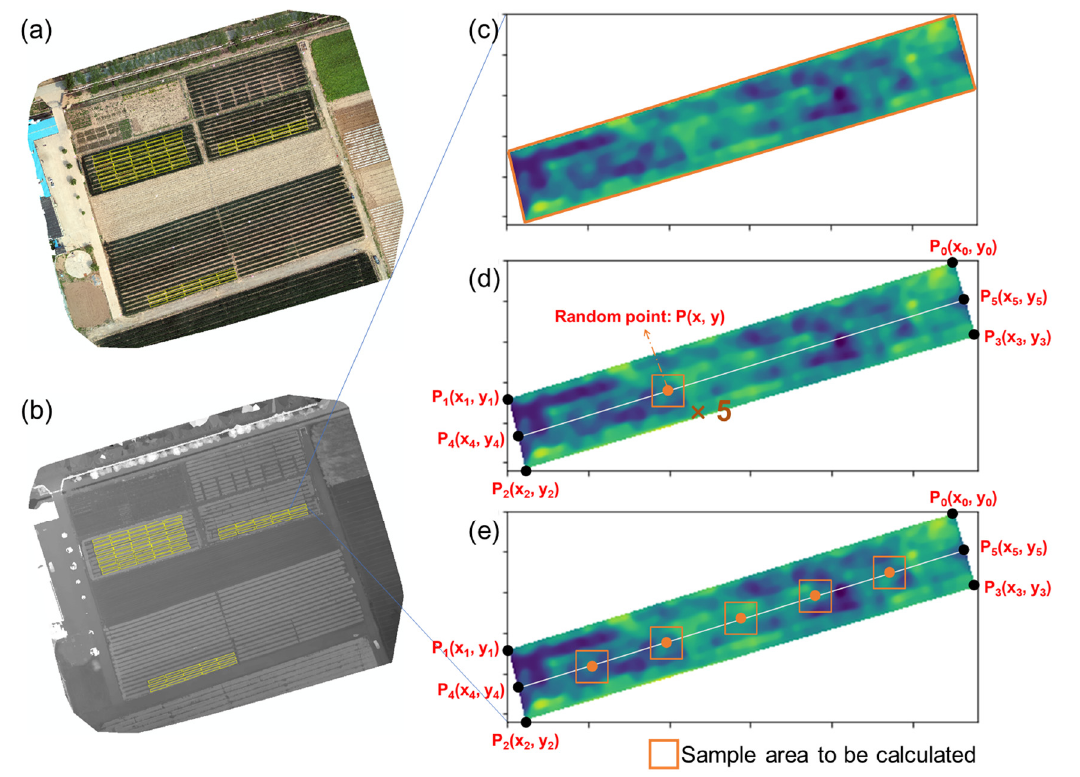
Figure 2. Models and sampling methods used for plant height estimation. ( a ) Orthomosaic; ( b ) Digital surface model; ( c ) Sampling method 1: whole region calculation; ( d ) Sampling method 2: random sampling; ( e ) Sampling method 3: equal interval sampling.